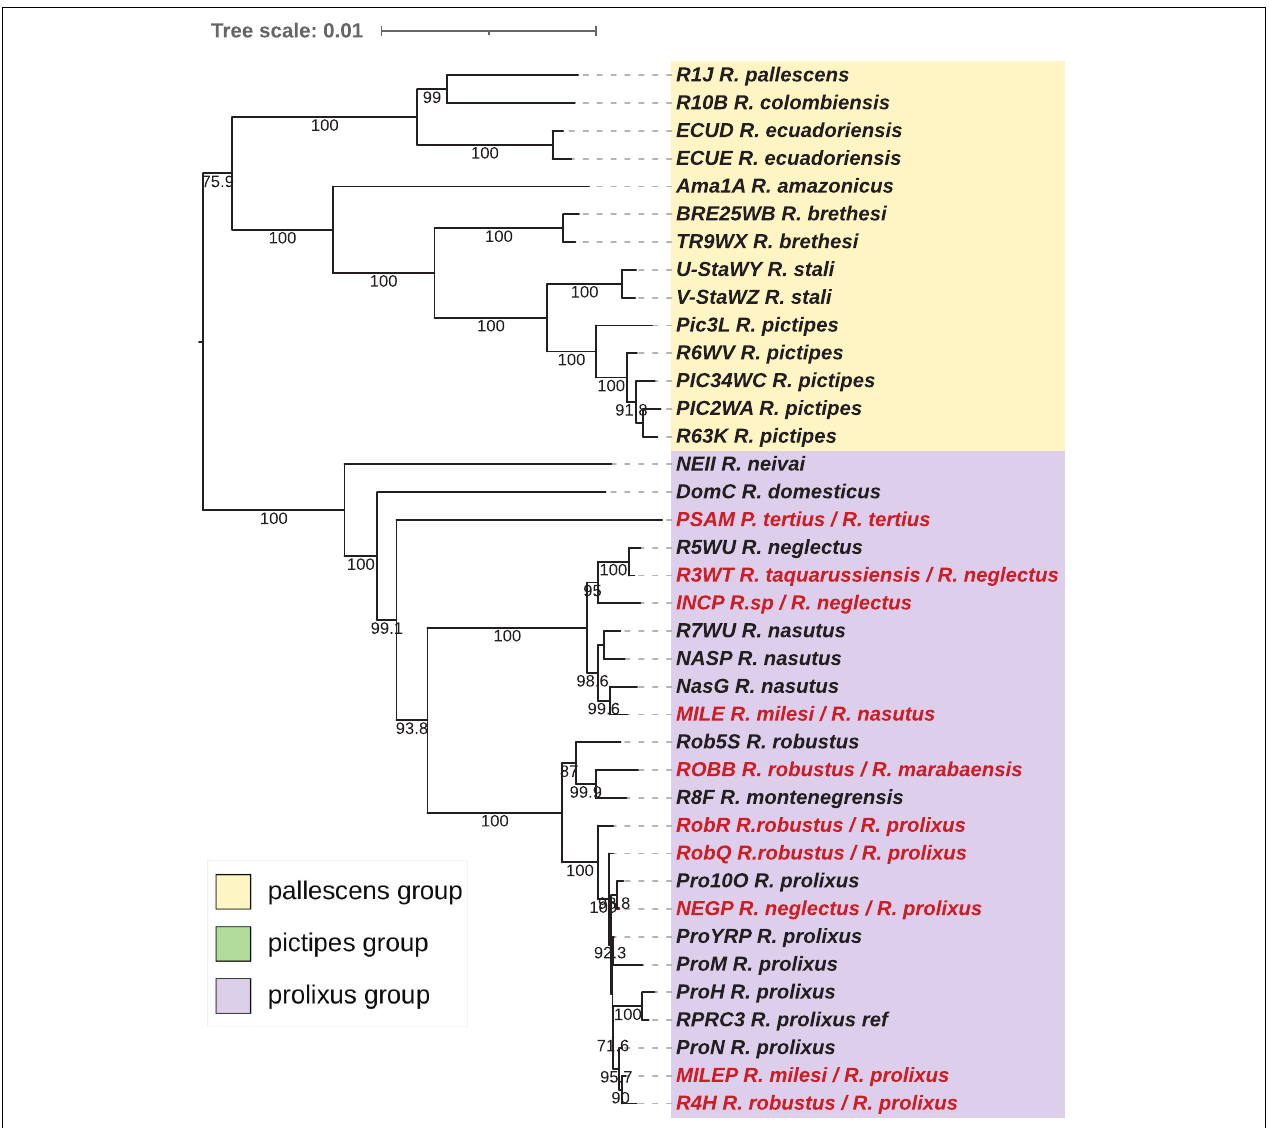
FIGURE 5 | Phylogenetic inferences for the concatenated nuclear protein-coding gene (nu-PCGs) dataset for Rhodnius species with the Maximum Likelihood (ML) method. The statistical supports (1,000 replicates SH-aLRT) are indicated on the nodes. T. brasiliensis was used as outgroup. Misidentified species are indicated in